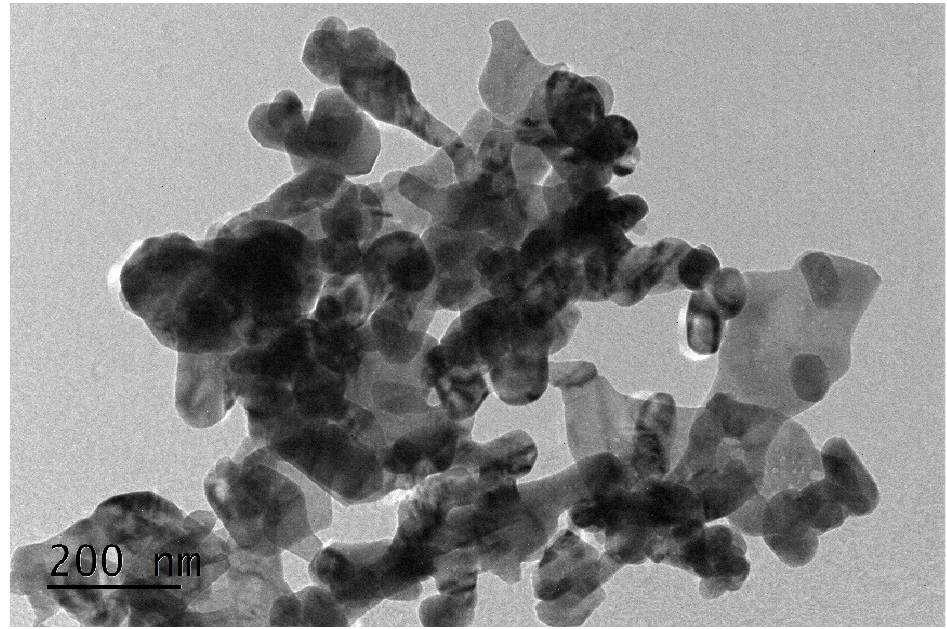
Figure 1. TEM image of CuO nanoparticles in water (0.1 g/L, pH 7.5). Keeping in mind that the surface charge of the particles might decrease in the bath solution (due to the increase in ionic strength), PEI was added to the CuO suspension